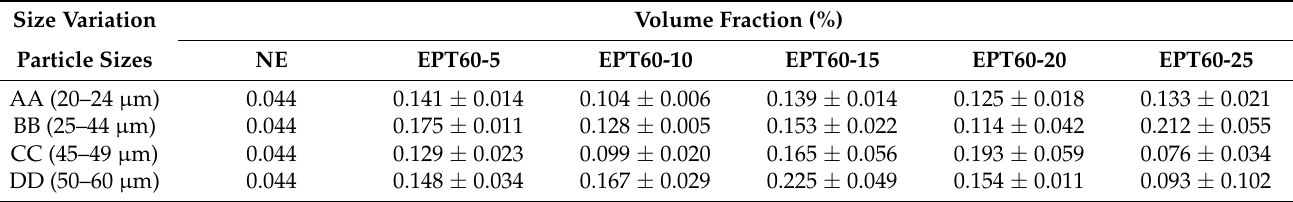
Table 5. Flexural strain of SFC filled with HGM-epoxy resin